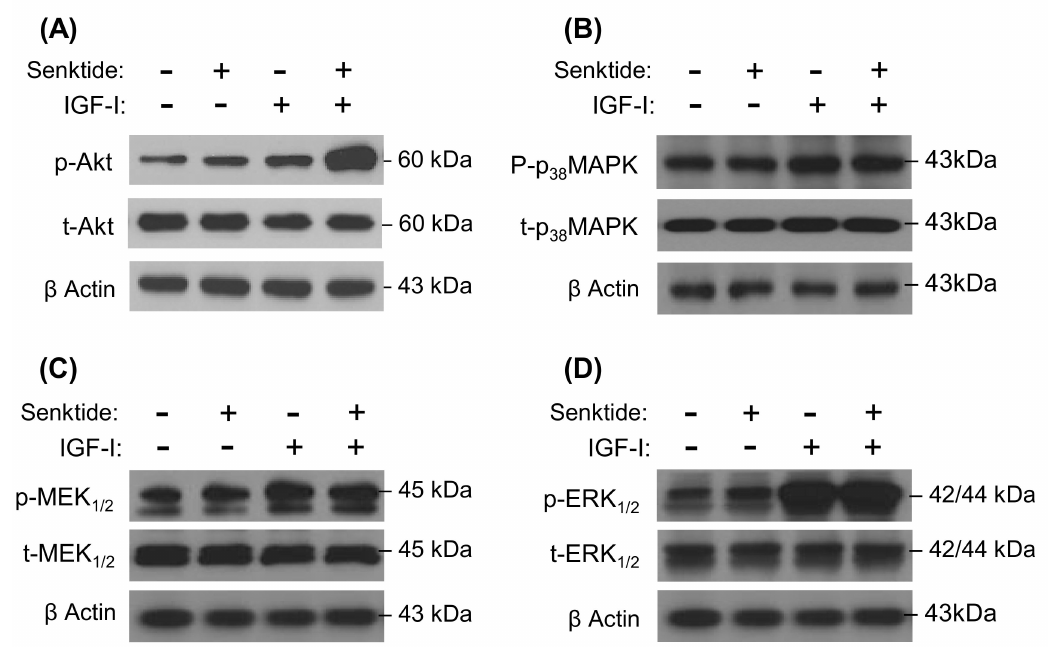
Figure 6. E ff ects of senktide, IGF-I, and senktide + IGF-I on protein phosphorylation and total protein production of Akt, p 38 MAPK, MEK 1 / 2 , and ERK 1 / 2 in grass carp pituitary cells: Senktide (1 µ M), IGF-I (50 nM), or senktide (1 µ M) + IGF-I (50 nM) were used to incubate grass carp pituitary cells for 15 min. After that, cell lysate was prepared, size fractionated by SDS-PAGE, and subjected to Western blot using the antibodies for phosphorylated form (p-) and total protein (t-) of MEK 1 / 2 , ERK 1 / 2 , Akt, and p 38 MAPK. In these experiments, parallel blotting for β -actin expression was routinely performed to serve as a loading control for Western